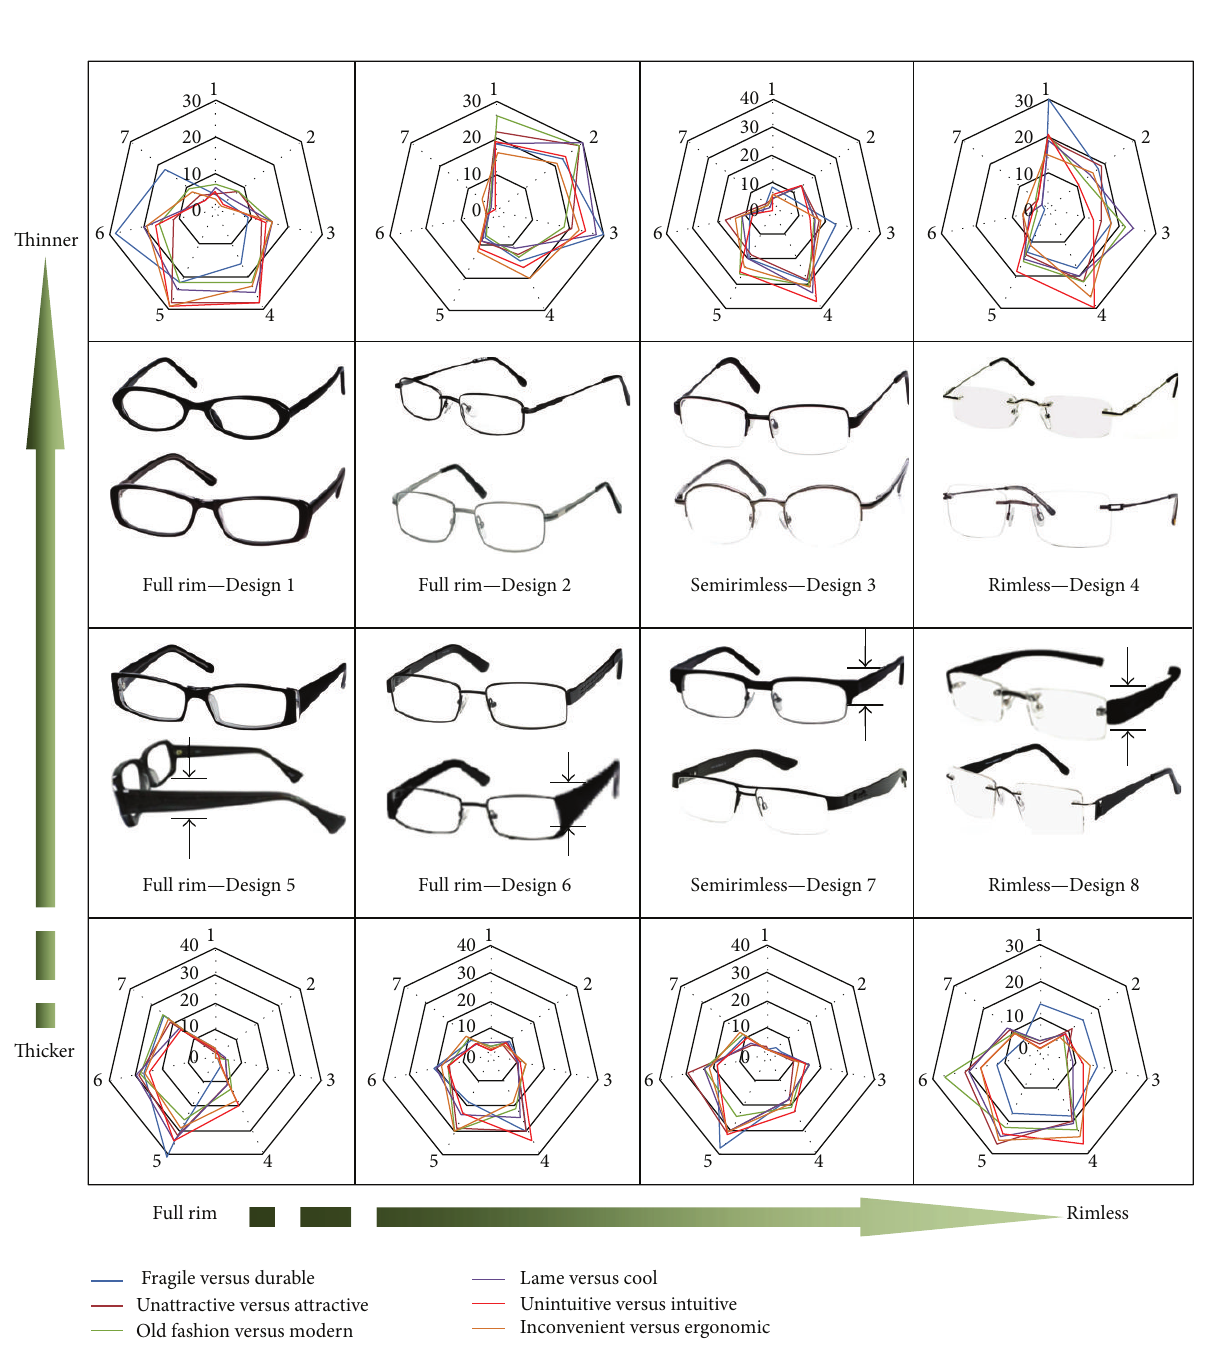
Figure 5: The Spider Web Chart mapping of the designs proposed based on Kansei